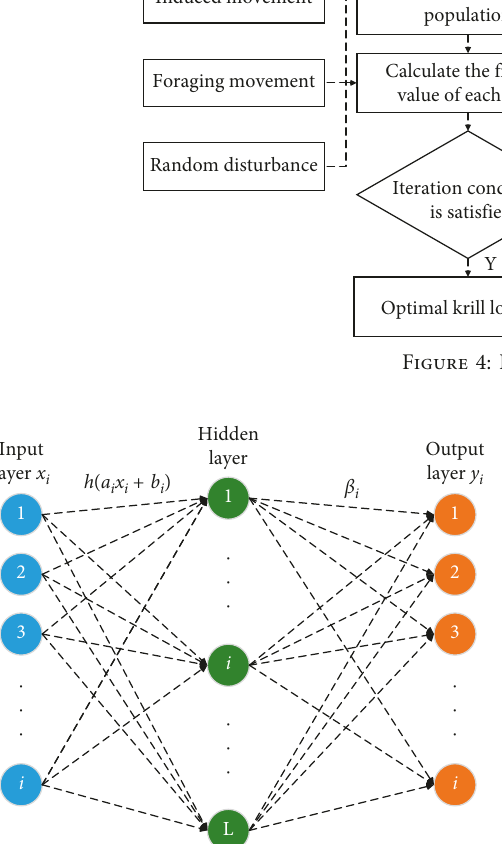
Figure 5: Flow chart of the